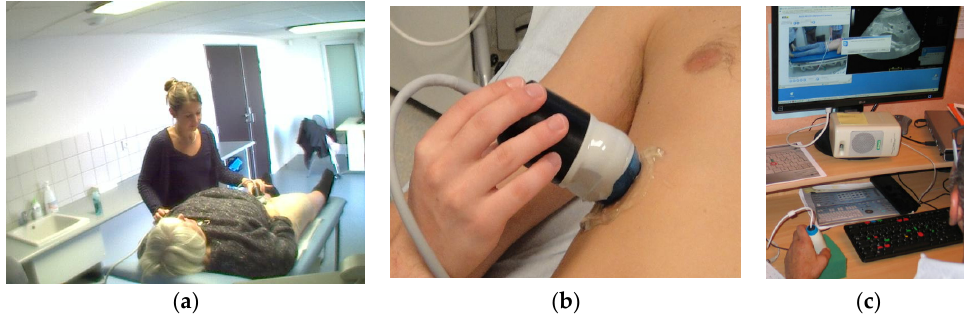
Figure 3. ( a ) General view of the isolated site with the MP held motionless on the patient by the non ‐ sonographer operator (GP); ( b ) Probe with transducer tele ‐ operated inside; ( c ) The expert with the dummy probe in hand, echograph function/settings teleoperation keyboard, and screen with ambient video and echographic view.